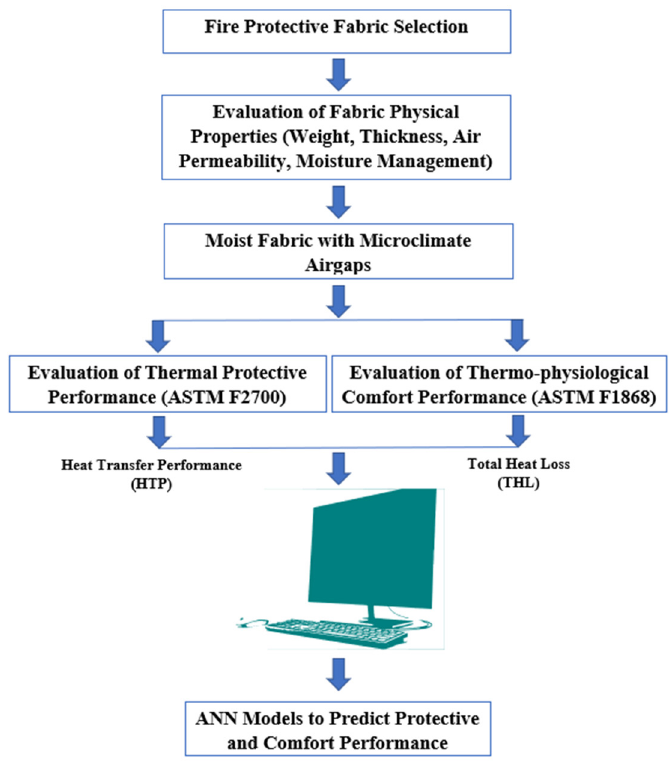
Figure 1. Research methodology. Table 1. Selected fabrics and their properties.